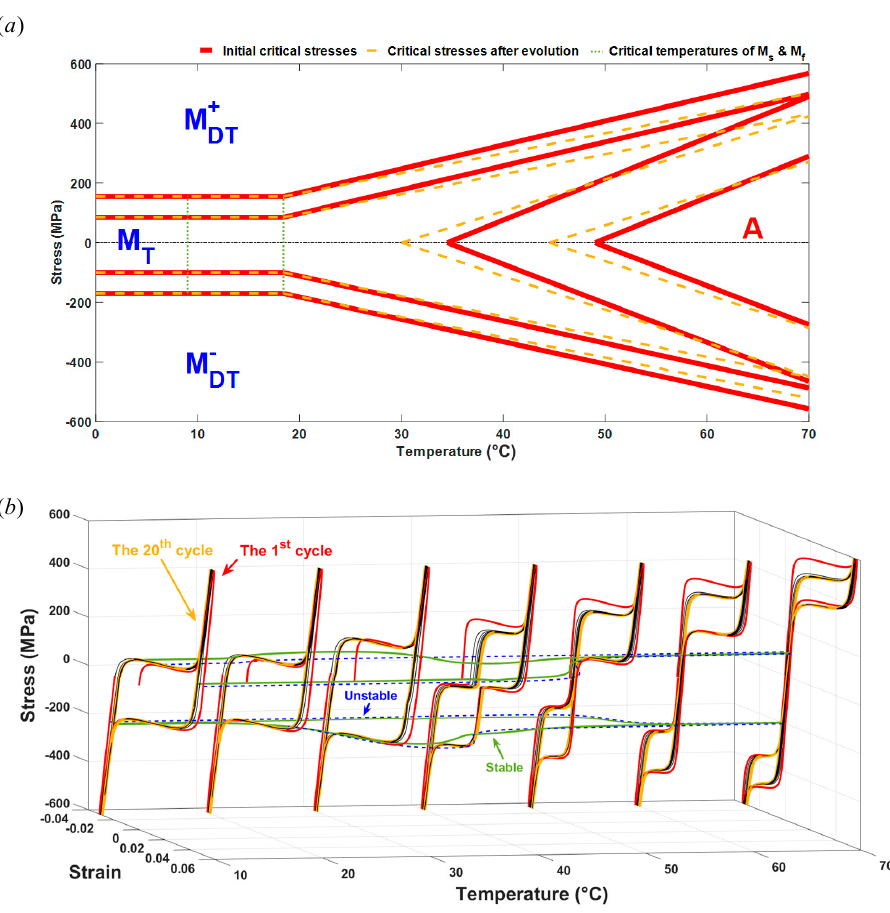
Figure 6. The temperature-dependent constitutive behavior of SMAs in the temperature range from 0 ° C to 70 ° C. ( a ) The asymmetric temperature-stress phase diagram predicting the critical stresses, red solid lines represent the initial critical stresses and the dark yellow dotted lines represent the critical stresses after evolution; ( b ) The strain–stress-temperature relationships of SMAs at various temperatures, red lines and the dark yellow lines represent the strain–stress relationships for the first and 20th cycles, respectively, the blue dashed lines represent the unstable strain-temperature relationship for the first cycle, and the green solid lines represent the stable strain-temperature relationship for the 20th cycle.